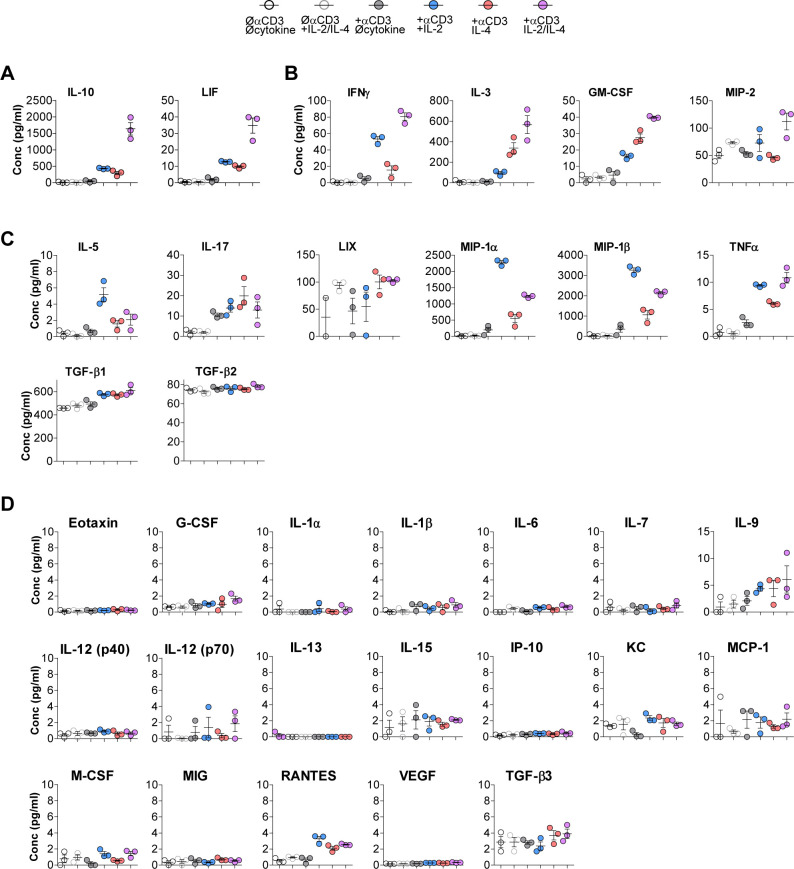
IL-10 is the only synergistic and robust analyte produced by Tregs following combinatorial cytokine stimulation 31-plex.Luminex analysis of cytokines secreted into the media following the designated stimulation conditions grouped in cytokines that (A) synergistically increase with combinatorial cytokine stimulation, (B) are summative, (C) show no change compared to single cytokine stimulation, and (D) are not highly expressed. Related to Figure 1I and J. N = 3. For all panels, mean ± SEM are indicated.